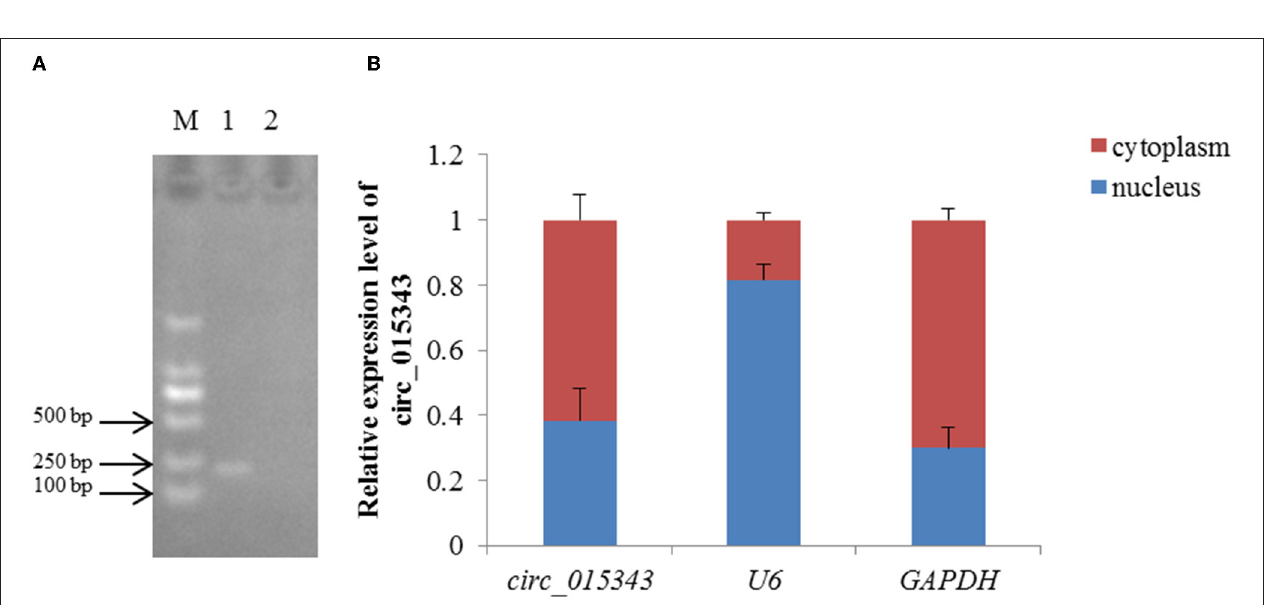
FIGURE 2 | Subcellular localization of circ_015343. (A) The RT-PCR expression of circ_015343 in cytoplasm and nucleus of ovine mammary epithelial cells detected by using agarose gel elecrophoresis. M: marker. Numbers above lane indicates the components of ovine mammary epithelial cells studied: 1: cytoplasm; 2: nucleus. (B) The RT-qPCR expression level of circ_015343 in cytoplasm and nucleus of ovine mammary epithelial cells of which was separated by cytoplasmic nucleus separation kit. The genes U6 and GAPDH were used as internal references.